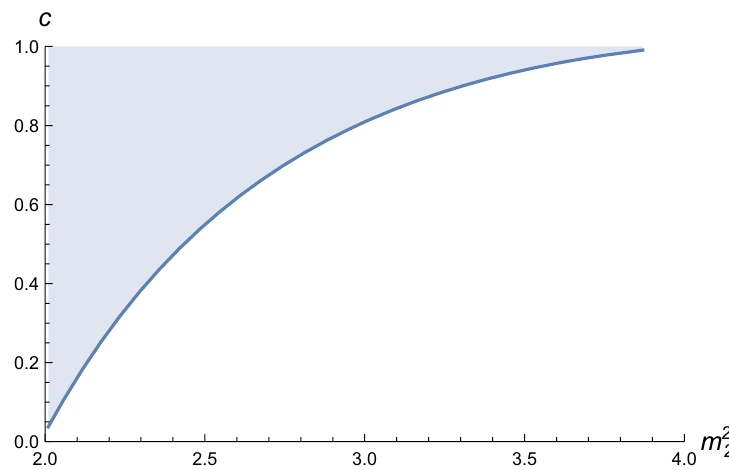
Figure 7 . Lower bound on the UV central charge obtained with N max = 30 as a function of m 2 with the trilinear coupling g (cid:12)xed to be the one of the sine-Gordon model. The allowed region is depicted in